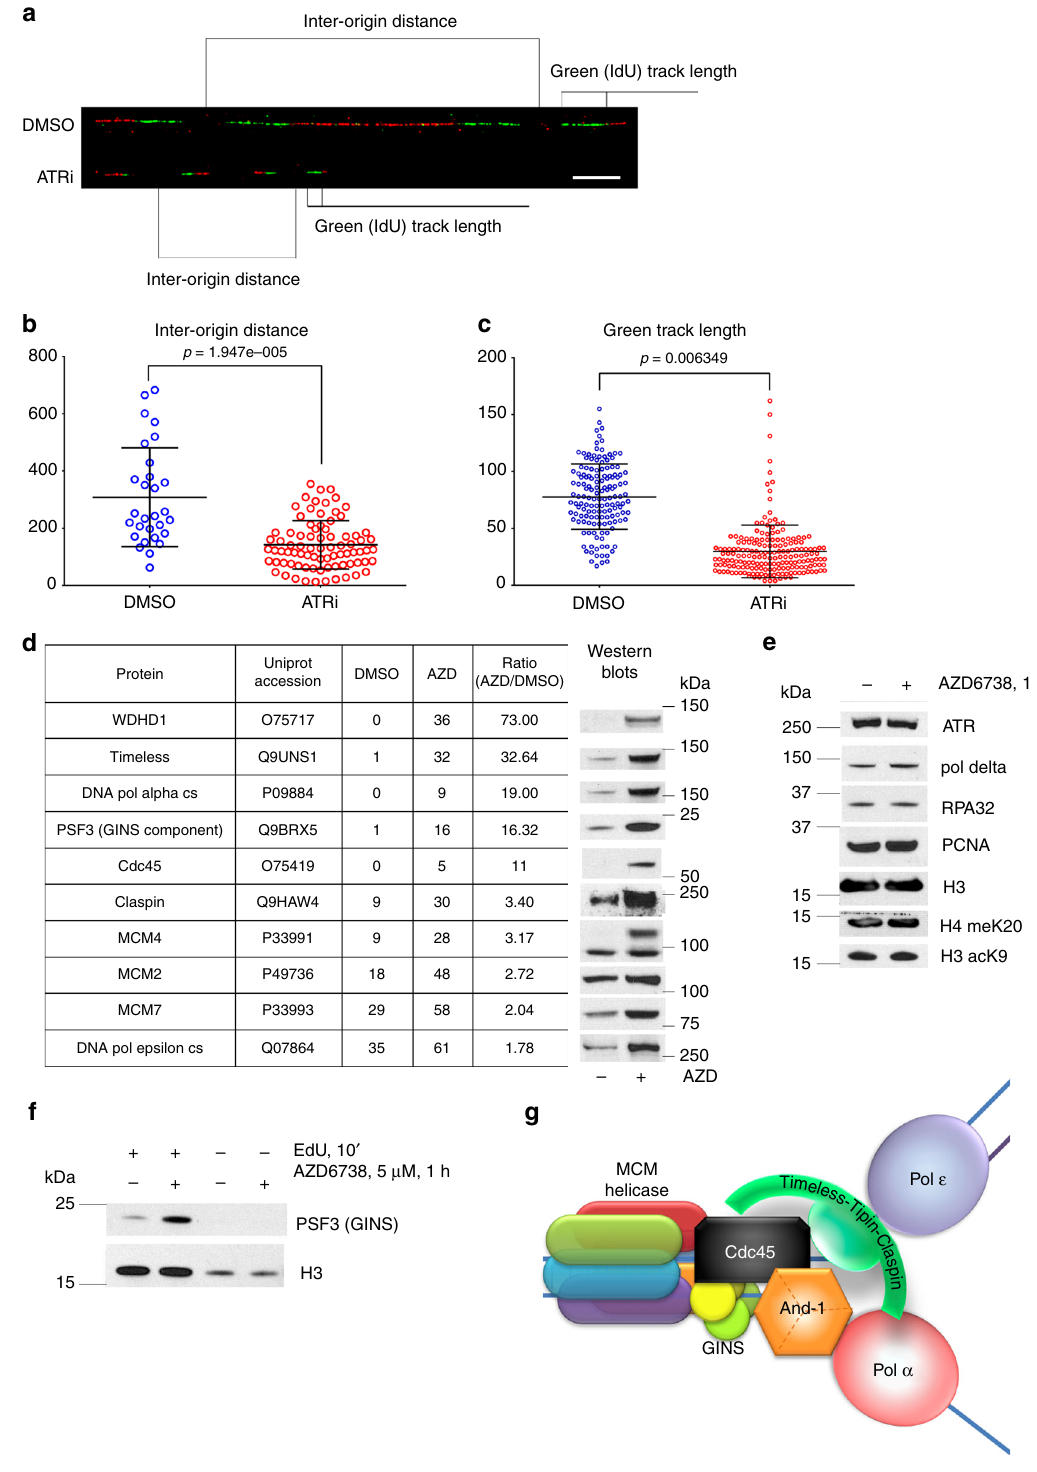
Fig. 1 ATR inhibition induces origin fi ring and an accumulation of the replication proteins in the insoluble chromatin fraction. a 293T cells treated with DMSO/5 μ M AZD6738 for 30 ′ before addition of IdU for 10 ′ followed by incubation with CldU for 20 ′ . Newly replicated DNA was analyzed by molecular combing, representative images are shown (IdU in green, CldU in red). Scale bar represents 10 μ m. b The inter-origin distances on molecular combing images were measured and analyzed. c The lengths of IdU (green) tracks on molecular combing images were measured and analyzed. For b and c , error bars represent standard deviation. d , e 293T cells were treated with AZD6738 or DMSO for 30 min and then fractionated. Nuclease-insoluble fraction was analyzed by mass spectrometry showing increase of the proteins involved in replication. Western blots con fi rm the MS results. f After 1 h treatment with 5 μ M AZD6738, newly synthesized DNA was labeled with EdU for 10 min in presence of AZD6738 and pulled down with click chemistry protocol after cross-linking the proteins to DNA. Western blot analysis of the replication associated PSF3 protein (GINS component) is shown. g Schematic picture of the basic replication fork